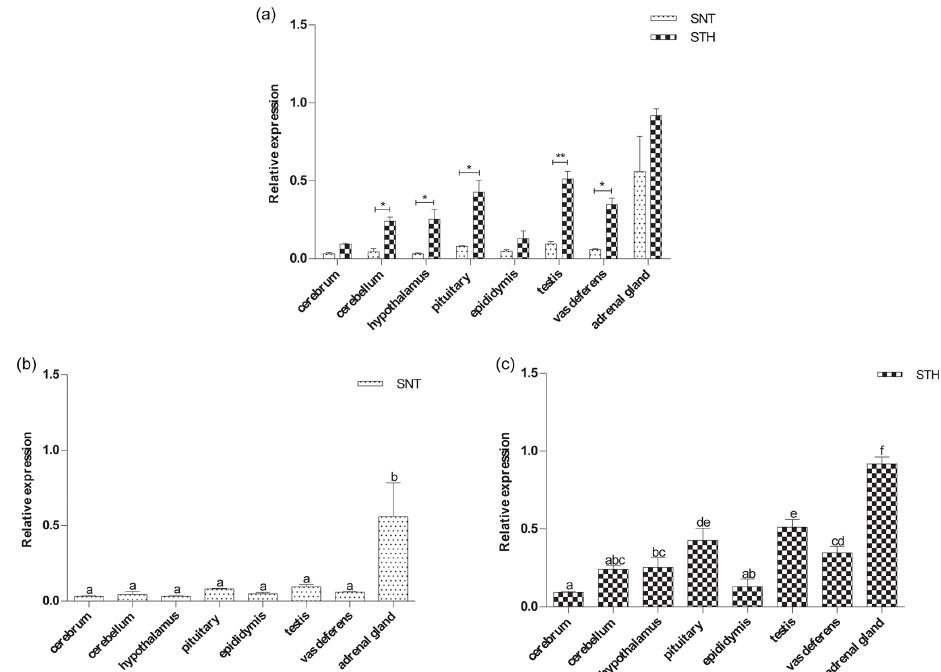
Figure 2. The expression of EYA3 in eight tissues of small-tail Han sheep (STH) and Sunite sheep (SNT): (a) the comparison of the expres- sion between SNT and STH, (b) the expression in SNT and (c) the expression in STH. Means with different superscripts are significantly different ( P < 0 . 05). The significant results with a p value lower than 0.05 are given one asterisk ( ∗ ) and lower than 0.01 are given two asterisks ( ∗∗ ),